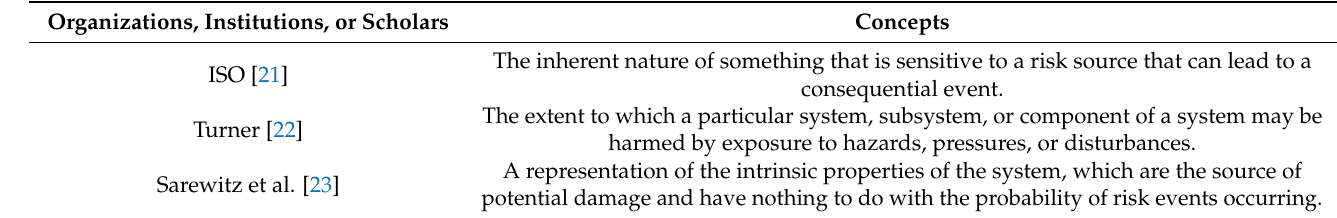
Table 1. Vulnerability-related